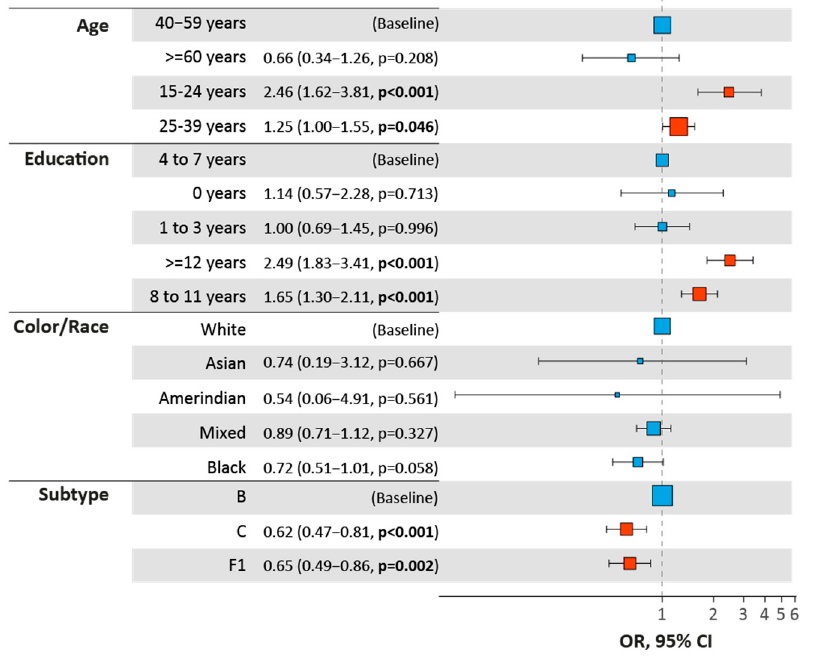
Figure 4. Percentage of clusters composed only by men or women and mixed clusters (clusters composed by men and women), for subtypes B, C and F1, identified with three genetic distances.